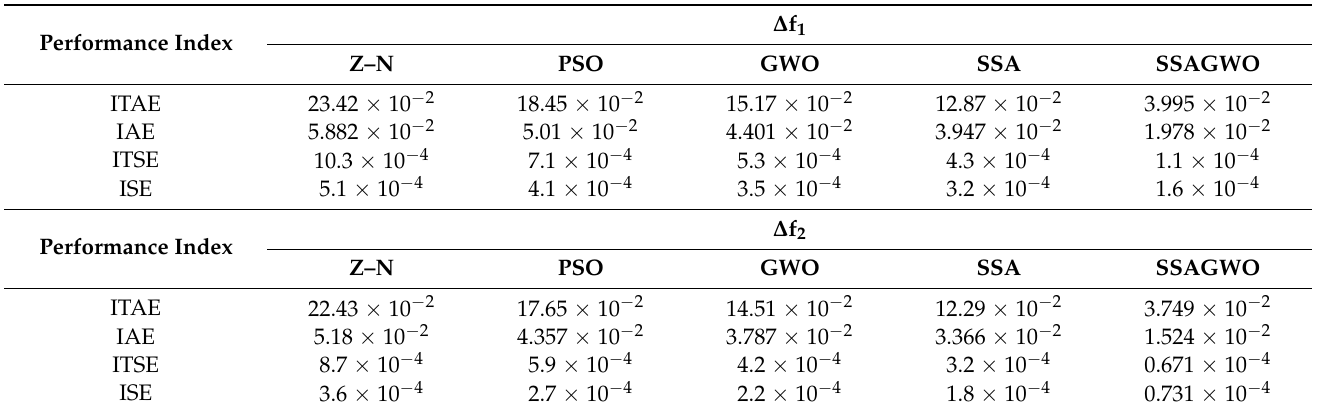
Table 9. Steady-state indices in case